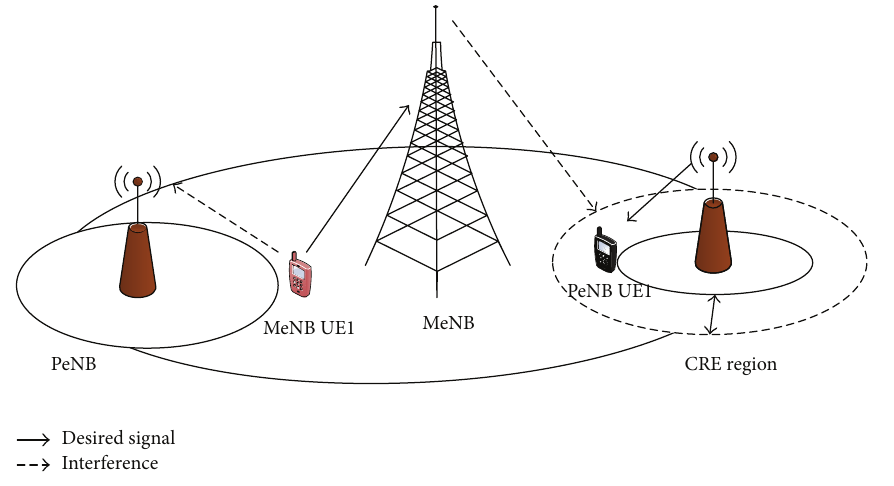
Figure 1: MeNB-PeNB deployment scenario [3].